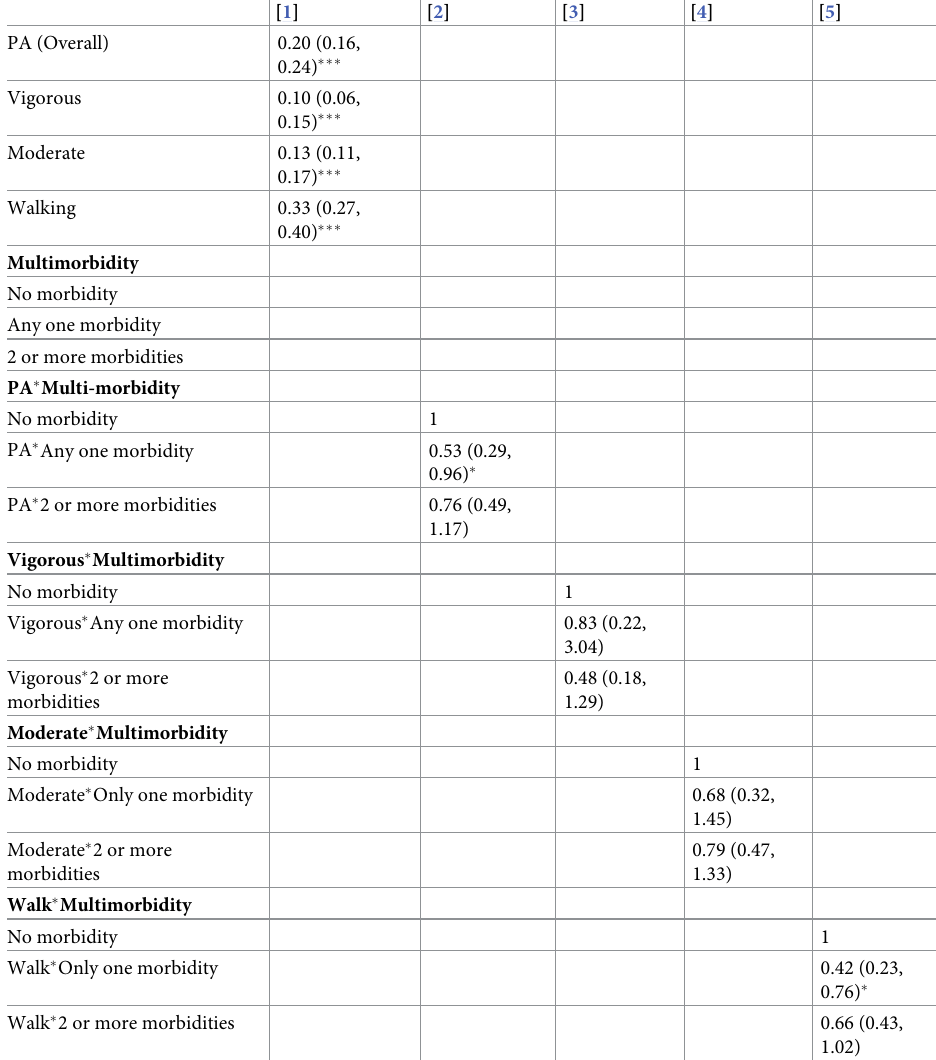
Table 4. Multimorbidity moderation on physical activity association with functional